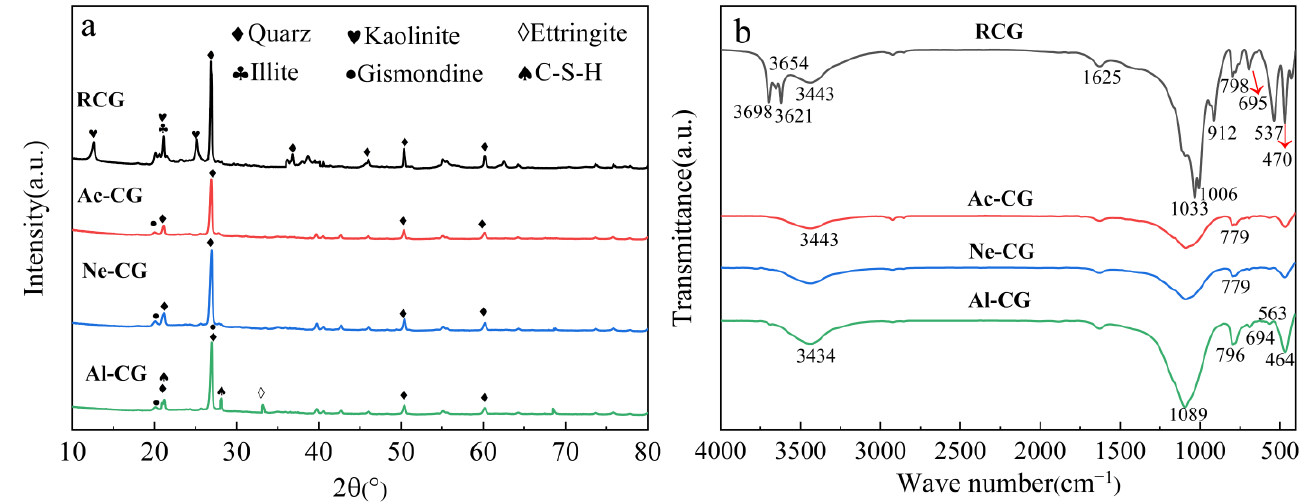
Figure 1. XRD patterns ( a ) and FTIR curves ( b ) of coal gangue samples.